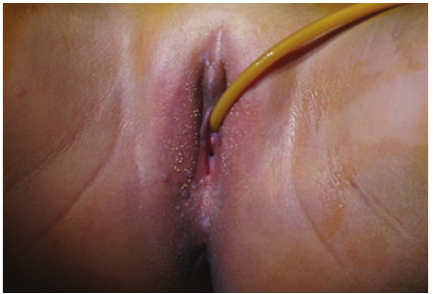
Figure 1: Type 1 FGM.